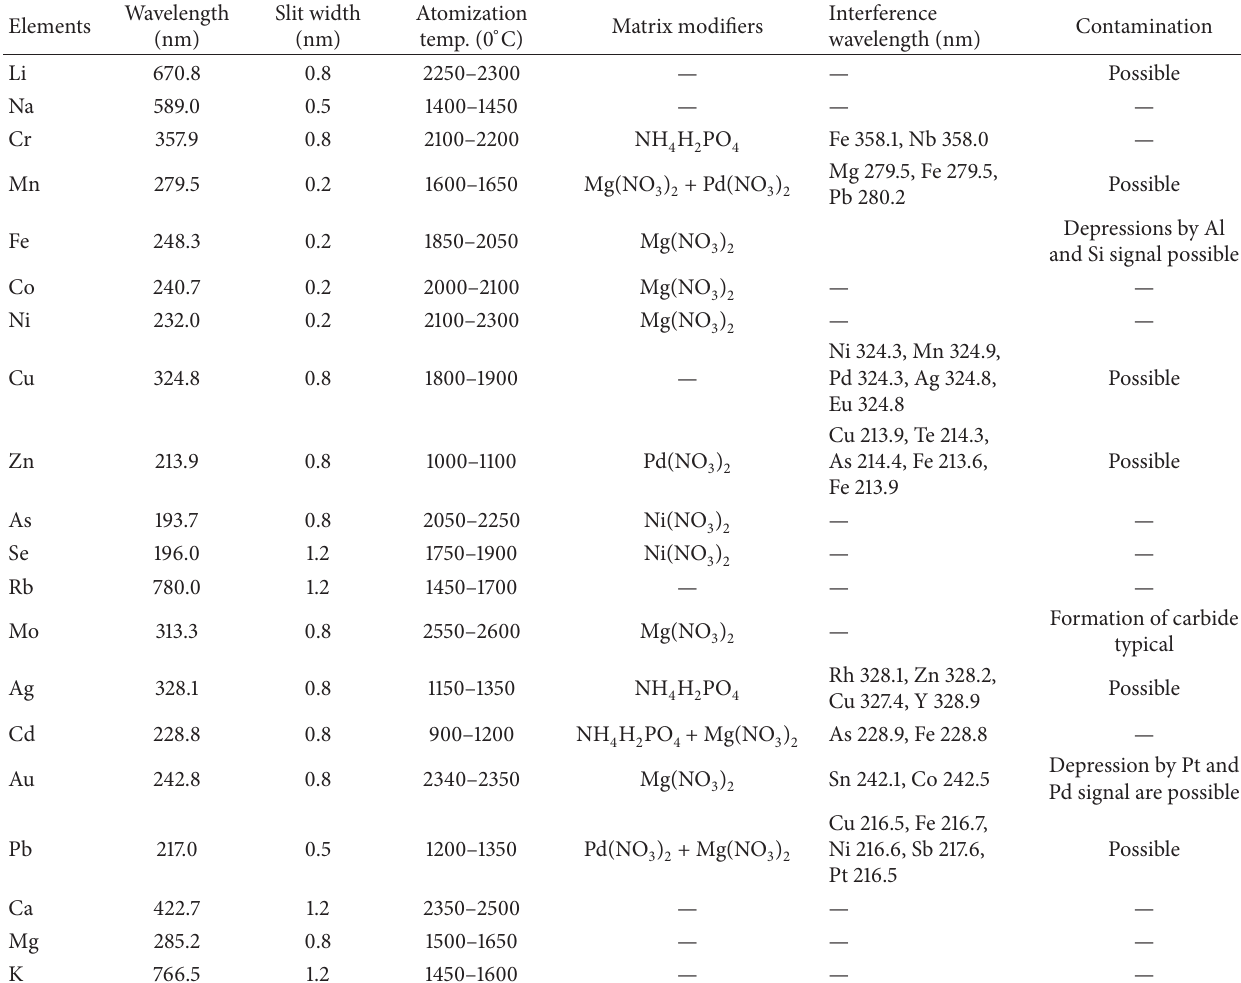
Table 1: AAS Vario-6 graphite furnace elements instrumental analytical